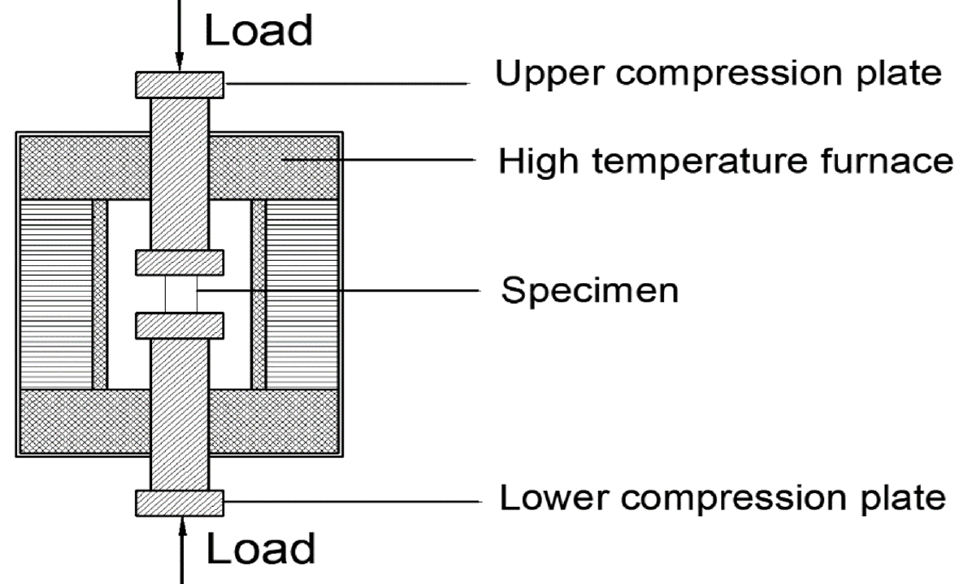
Figure 1. Automatic universal testing machine equipped with a temperature controllable box.